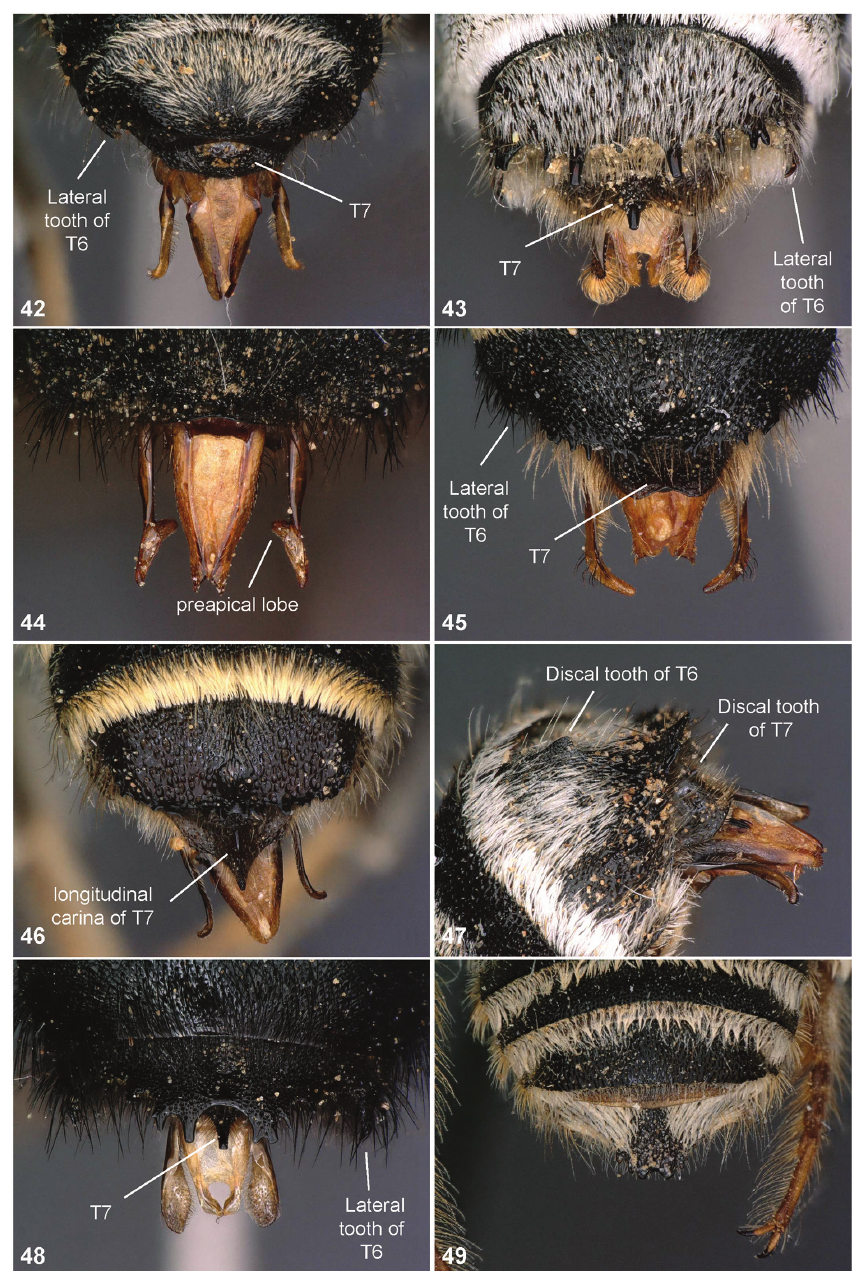
Figures 42–49. Apex of male metasoma; 42–46, 48 T5-T7 and apex of genital capsule, dorsal view 47 T5-T7 and apex of genital capsule, lateral view 49 T4-T6, dorsal view 42 Megachile ( Megachile ) melanopyga 43 M. ( Pseudomegachile ) sp . aff incana 44 M. ( Chalicodoma ) parietina 45 M. ( Chalicodoma ) hungarica 46 M. ( Creightonella ) albisecta 47 M. ( Creightonella ) doriae 48 M. ( Chalicodoma ) manicata 49 M. ( Eurymella ) patellimana